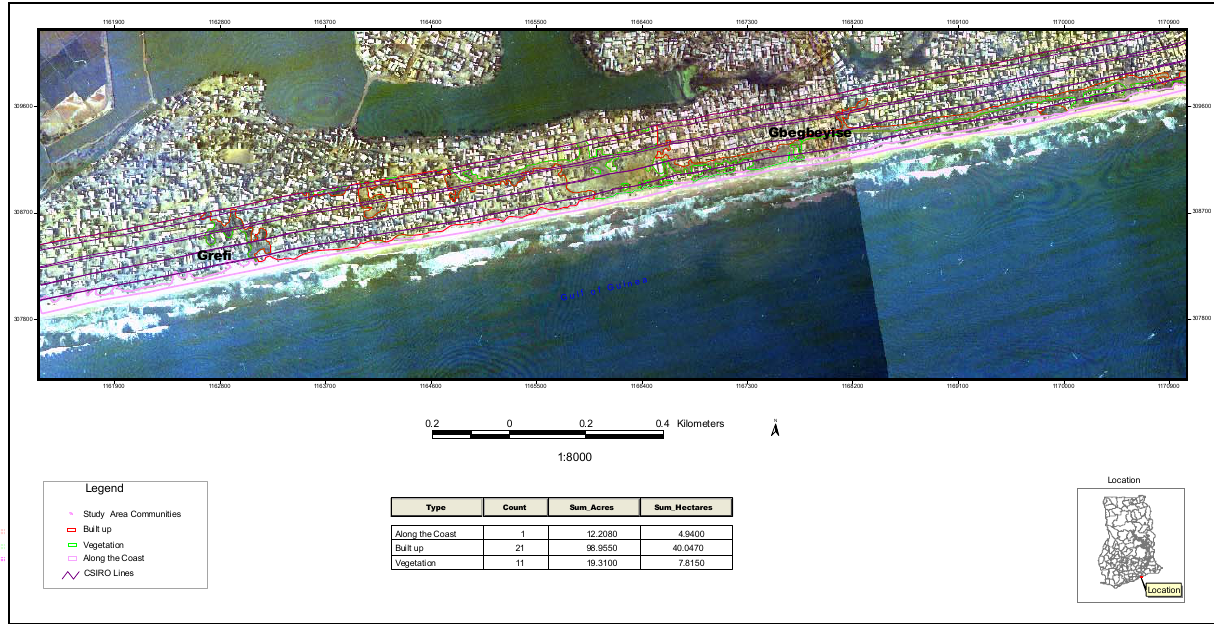
Figure 5. Settlement (red) and vegetated area (green) susceptible to permanent inundation.